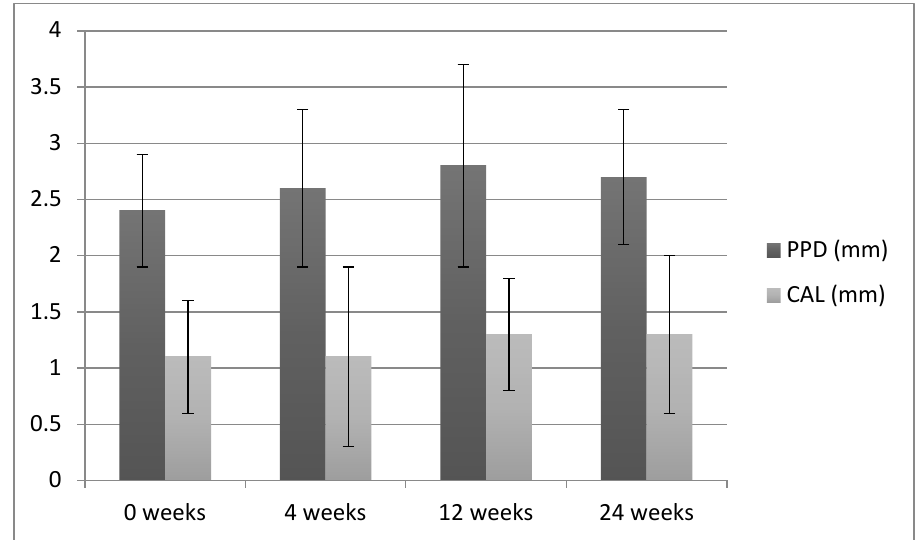
Figure 3. Comparison of periodontal pocket depth (PPD) and clinical attachment loss (CAL) in millimeters (mm) as observed at baseline and different follow-up durations in patients treated with lumineers. Table 2. G ingiva crevicular fluid (GCF) flow rate and periodontal parameters observed in the study.